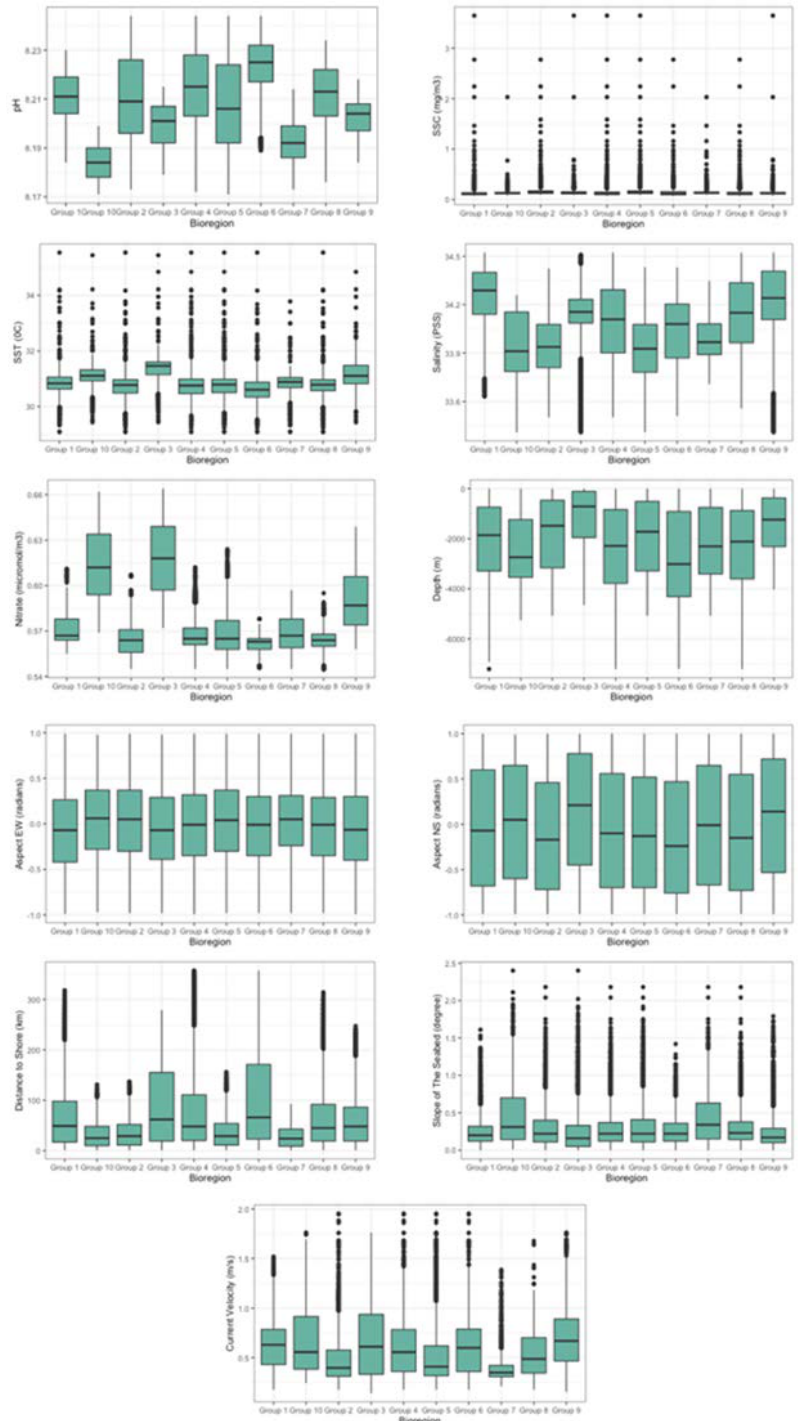
Fig. 6: Environmental characteristics of each FCM delineation group in the dry season